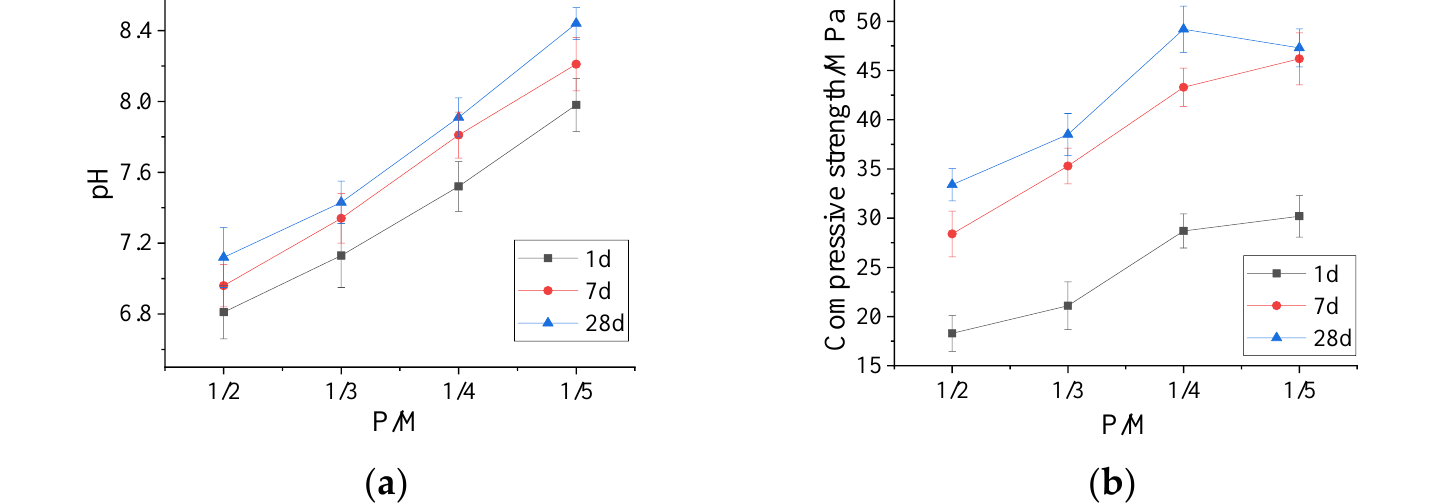
Figure 1. Effect of P/M on ( a ) alkalinity and ( b ) compressive strength of MPC. The compressive strength reaches a maximum value at a P/M of 1/4 (Figure 1b). The compressive strength of the MPC paste is mainly determined by the amount of unreacted MgO and hydration product named as struvite. When the P/M ratio is large (P/M =